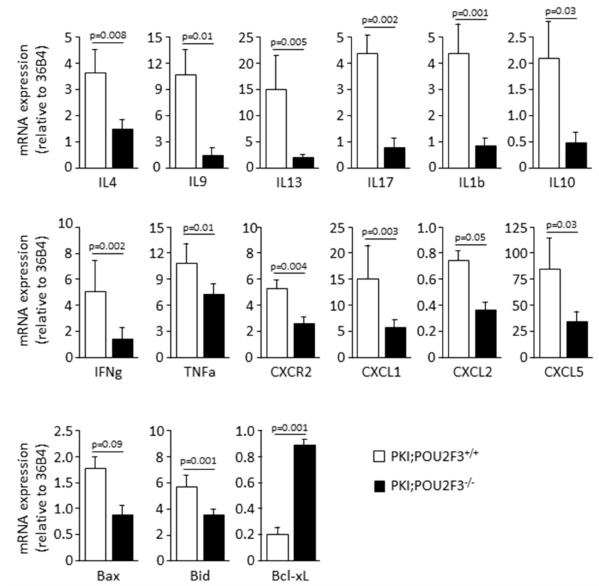
Figure 3. PDAC from PKI;POU2F3 − / − mice express less level of inflammatory markers and overexpress